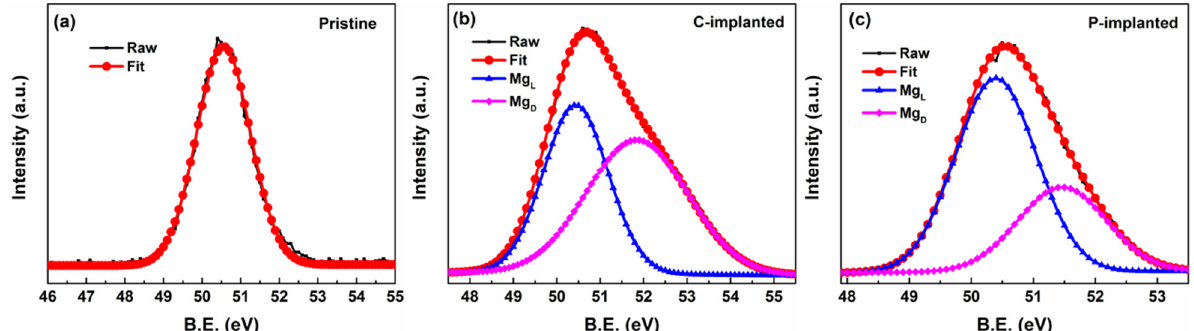
Figure 3. XPS core-level spectra of Mg 2p signal for ( a ) pristine, ( b ) C-implanted, and ( c ) P-implanted MgO samples. The black solid lines represent the original XPS data. The red, blue, and pink scatter-lines represent the fitted bonding states.